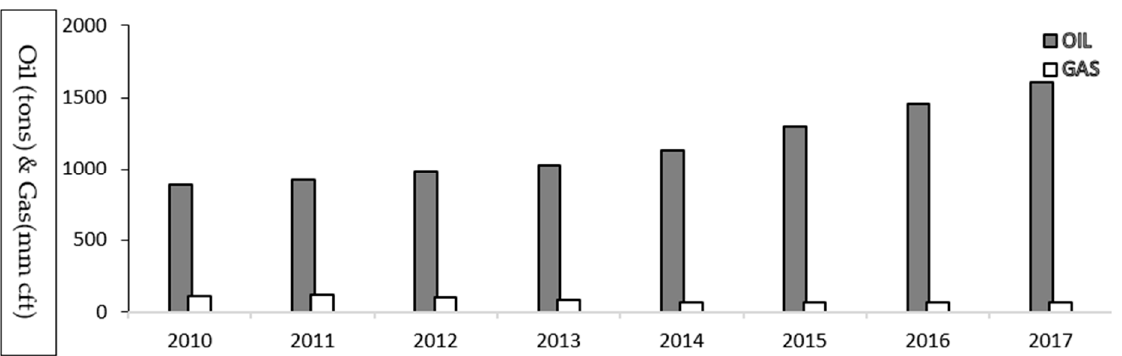
Figure 1. Energy demand trend of Pakistan’s transport sector from 2010 to 2018. Source: Authors’ construction. Data have been collected from the Reference [4].